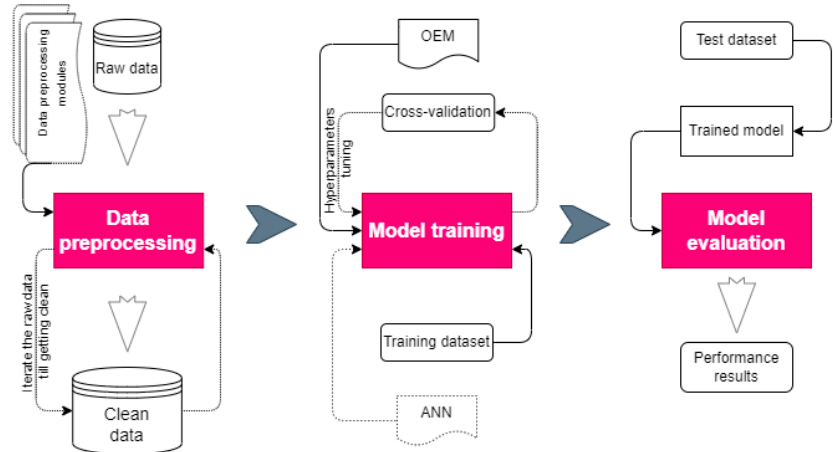
Figure 3. The pipeline of the prediction models OMC, MDD, and UCS.